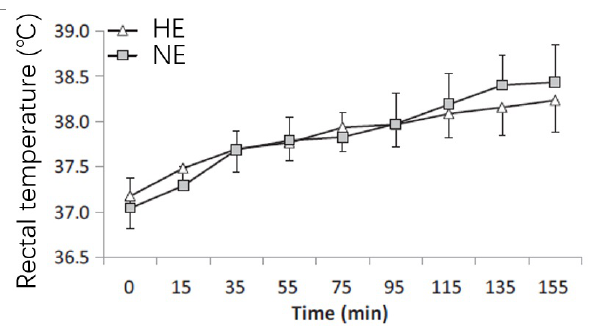
Fig. 3 Changes in the Tre of the subjects under exercise in the two environments. HE, high fever group; NE, control group; Tre, rectal